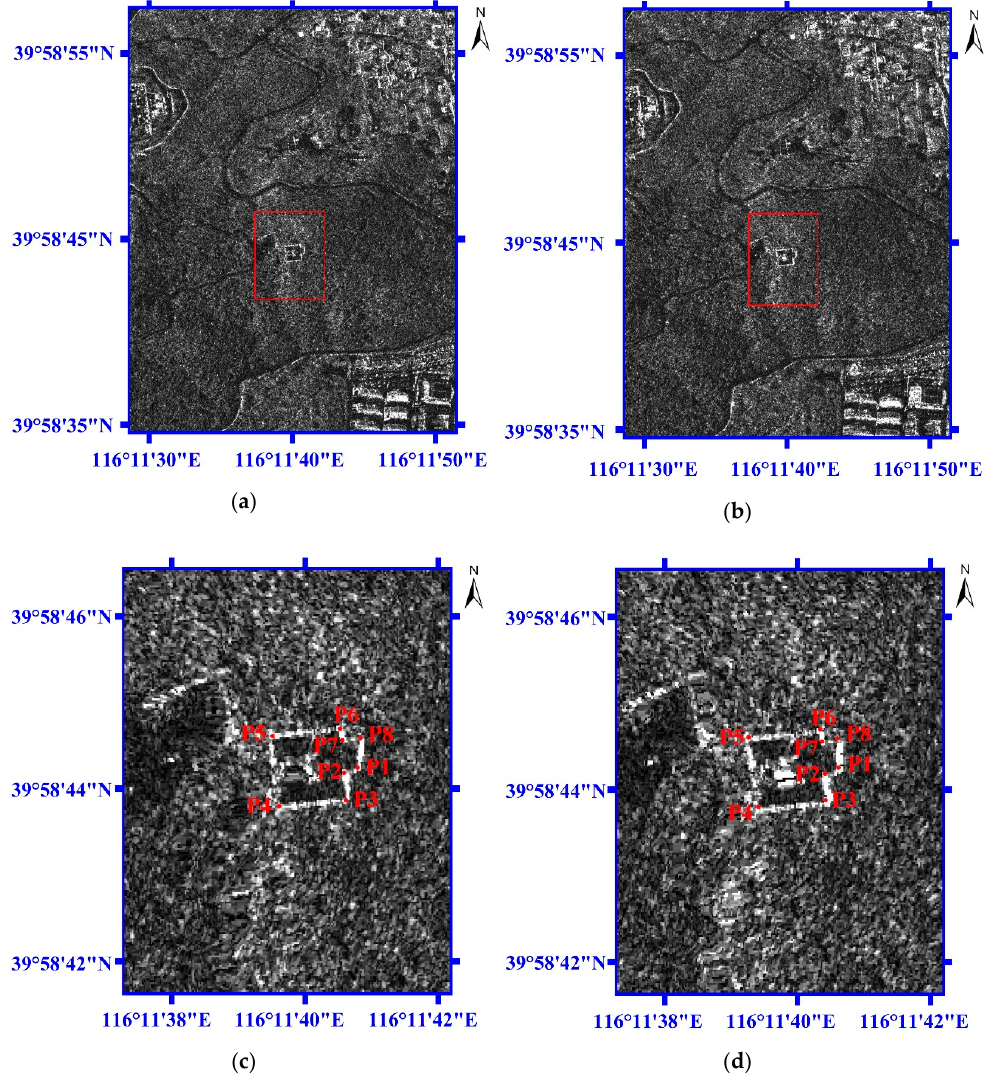
Figure 7. The geolocation results for Banshan Pavilion at Western Hills in Beijing. ( a ) The two-dimensional image for M1. ( b ) The two-dimensional image for M2. ( c ) The enlarged image for the red window (Area 1 in Figure 6) in Figure 7a. ( d ) The enlarged image for the red window (Area 1 in Figure 6) in Figure